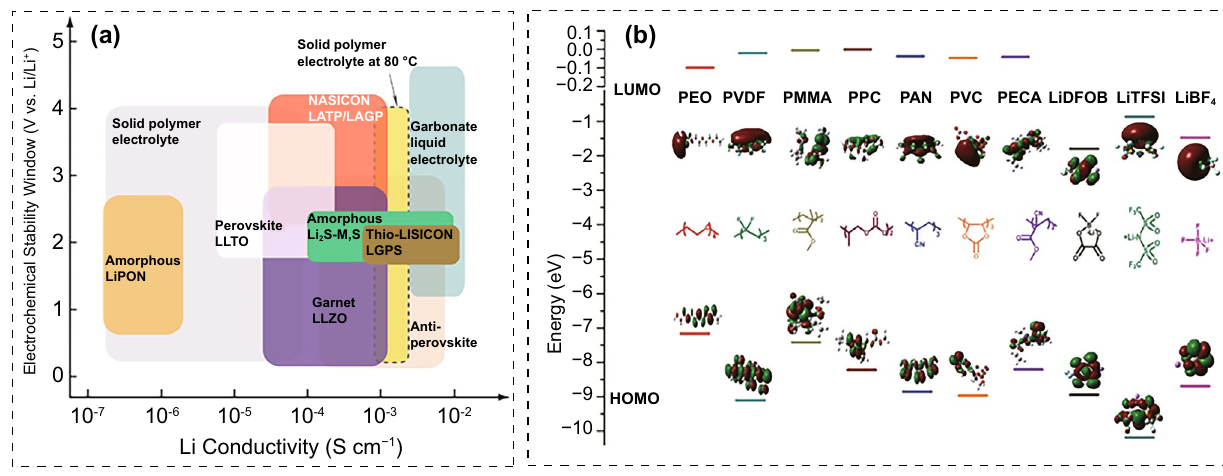
Fig. 3 a Ionic conductivity and electrochemical window of different SSEs [33]. Copyright 2020, American Chemical Society. b HOMO and LUMO values of different polymers and lithium salts [32]. Copyright 2019, John Wiley and Sons